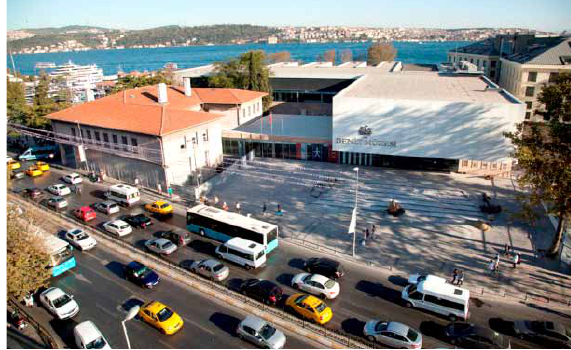
fig. 16. Istanbul naval Museum – general view (www.arkitera.com)